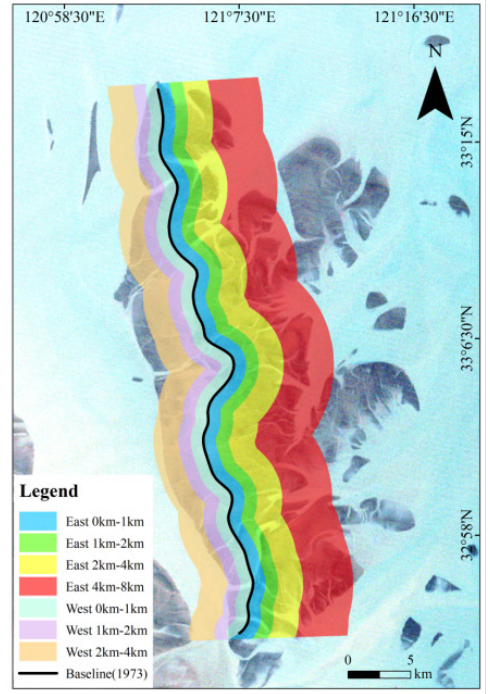
Figure 4. Determination of Dongsha Shoal buffer zone.